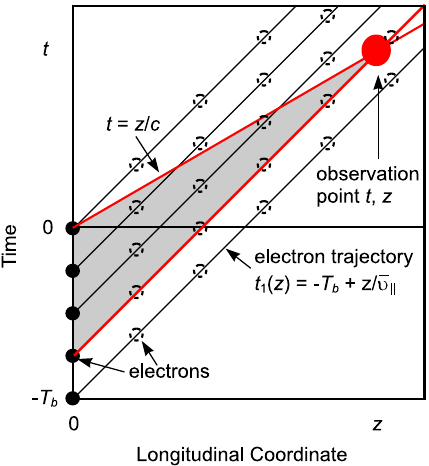
1. The space-time diagram of the longitudinal dynamics of the bunch electrons in the undulator. The radiation field observed at moment t and position z is created by electrons passing through the shaded